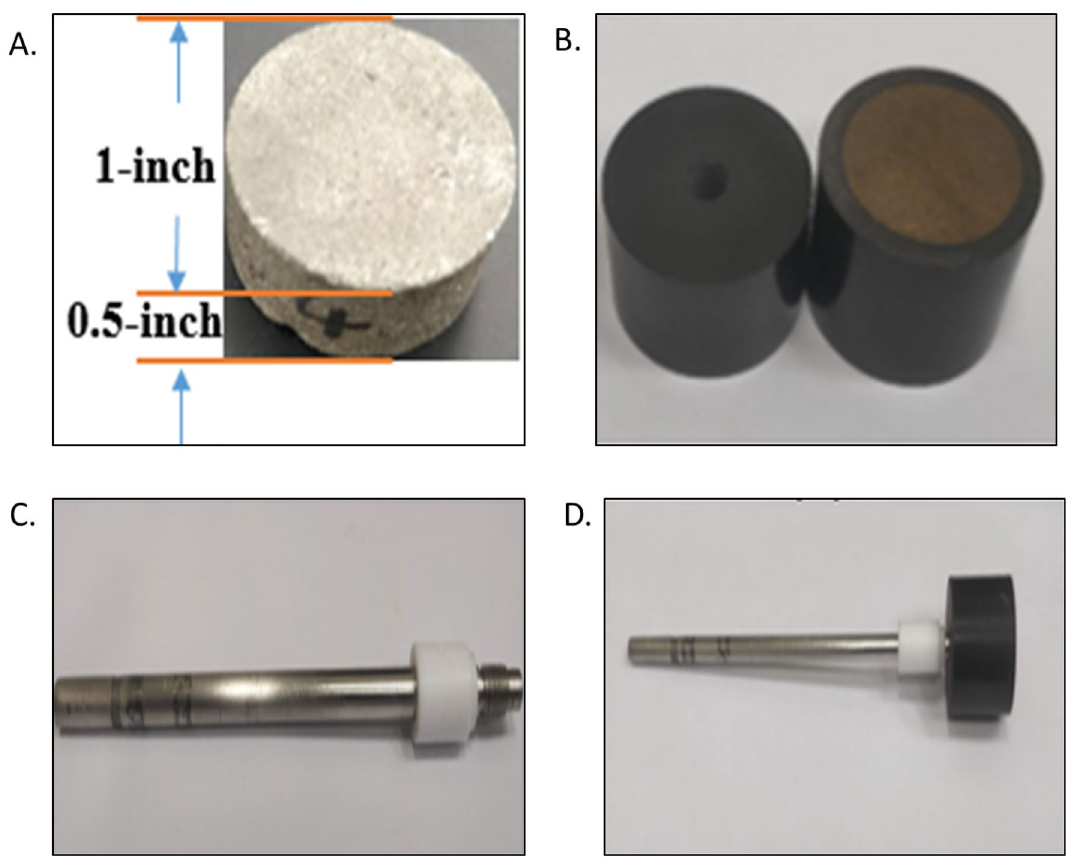
Figure 1. The (a) pyrite disk electrode with its dimension, (b) the insulator with the casted pyrite electrode, (c) rotating disk electrode (RDE) shaft, (d) coupled RDE shaft with pyrite electrode.